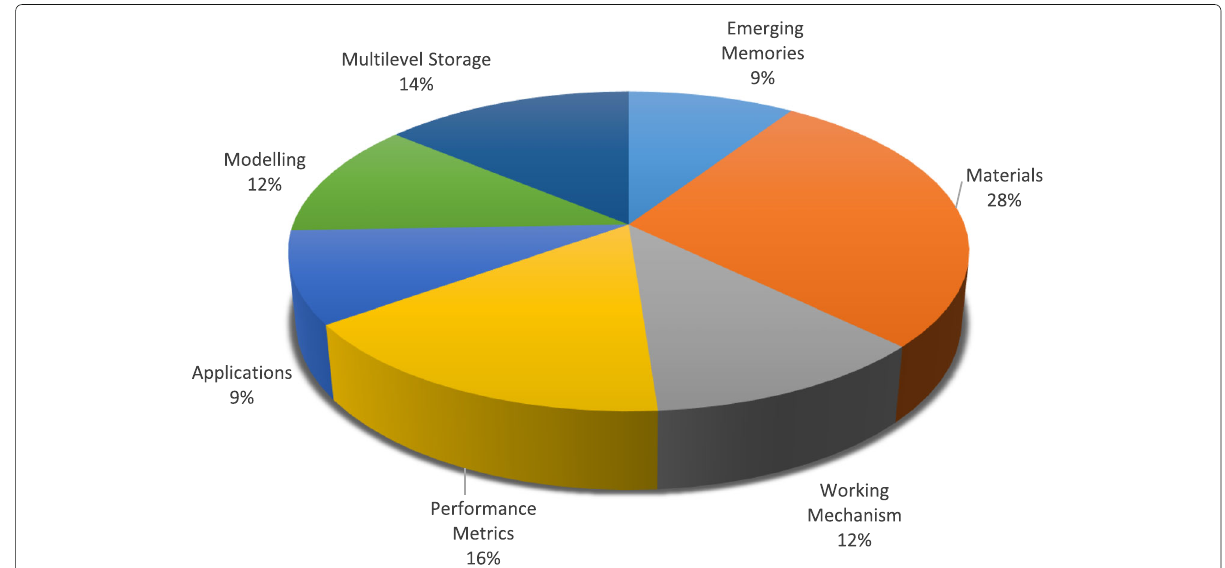
Fig. 2 Category wise distribution of papers consulted for preparation of review on RRAM